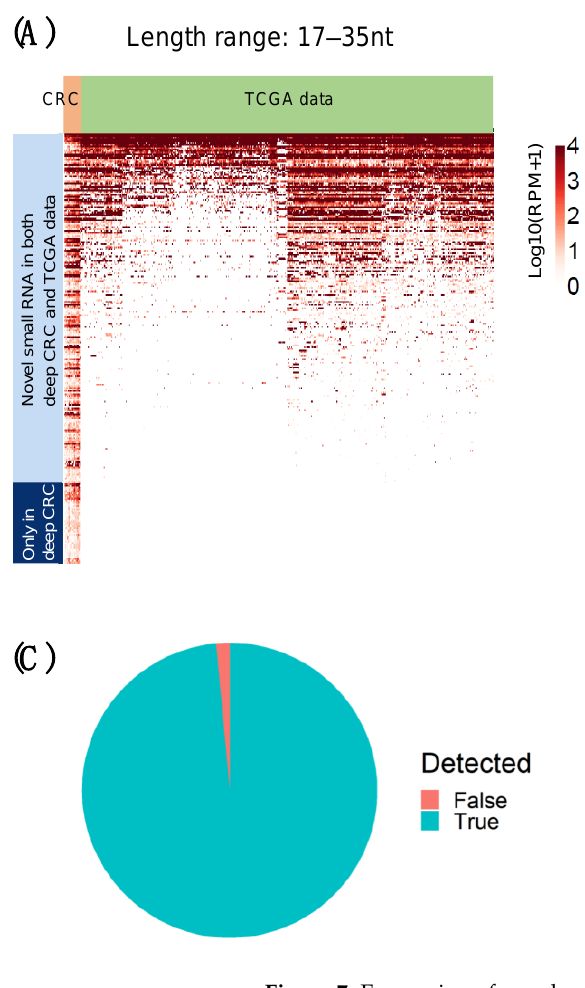
Figure 7. Expression of novel small RNA clusters detected by DANSR in the deep-sequenced CRC cohort among TCGA-COAD and TCGA-READ miRNA-seq samples. ( A ) A large majority of novel clusters at the short end of the length range (17–25 nt) are discoverable within the TCGA miRNA-seq samples (82%, or 207 of 255 novel small RNAs), and those that are present within the TCGA data tend to be expressed consistently across large numbers of samples. ( B ) Novel clusters at the longer end of the length range (36–200 nt) are still discovered within the TCGA miRNA-seq data, but due to the sequencing protocol’s focus on enrichment for miRNA in the 17–35 nt range, they are discovered at a lower rate (58%, or 40 of 68 novel small RNAs) and in a lower proportion of samples. This figure includes RNAs that were discovered in at least 50% of samples in the institutional CRC cohort. The full list of novel small ncRNAs is included in Table S3. ( C ) DANSR successfully detects 99% (466 out of 473) of miRNAs that TCGA reports as being expressed within either TCGA-COAD or TCGA-READ.